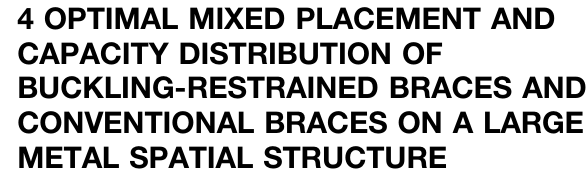
Frontiers in Built Environment |